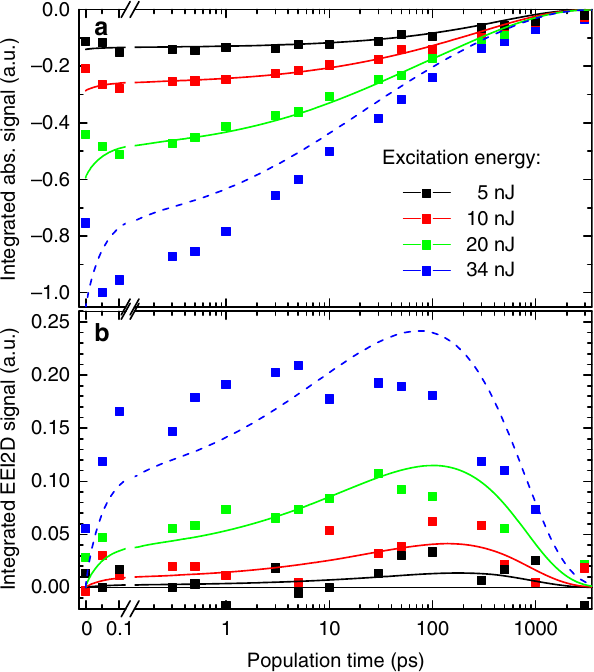
Fig. 5 Integrated time evolution of the 2D spectra. The two graphs show the time evolution of a the integrated experimental absorptive 2D and b the EEI2D spectra for various excitation intensities (symbols). The 5, 10, and 20 nJ experimental data sets are compared with their simultaneous best fi t of the theoretical model (solid lines). The 34 nJ dataset is compared with the same model prediction (dashed curve) using identical fi tting